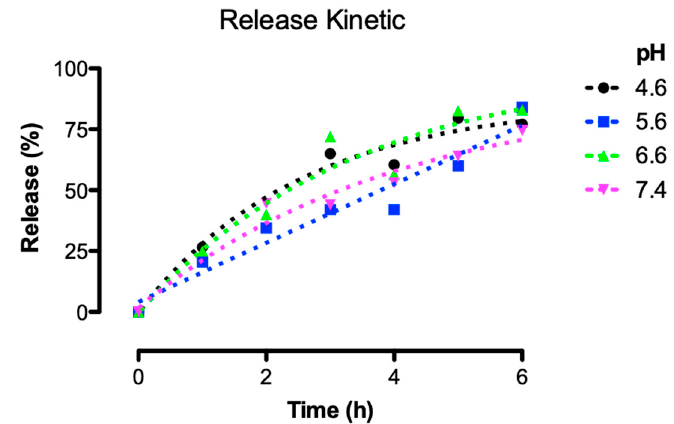
Figure 3. Release profile of encapsulated tarin exposed to pH 4.6, 5.6, 6.6, and 7.4, mimicking human body traits and cellular compartments . Tarin liposomal nanocapsules (A1 formulation) prepared through 0.2 µ m pore extrusion membrane were maintained at 36 ◦ C for 6 h. Tarin release was measured hourly, as described by Peterson [23].